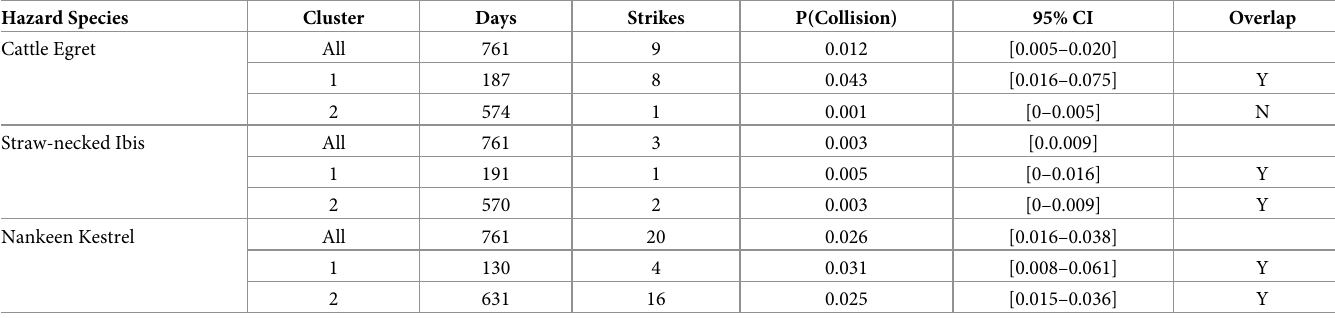
Table 5. Clusters, collision probability, and 95% confidence interval by hazard